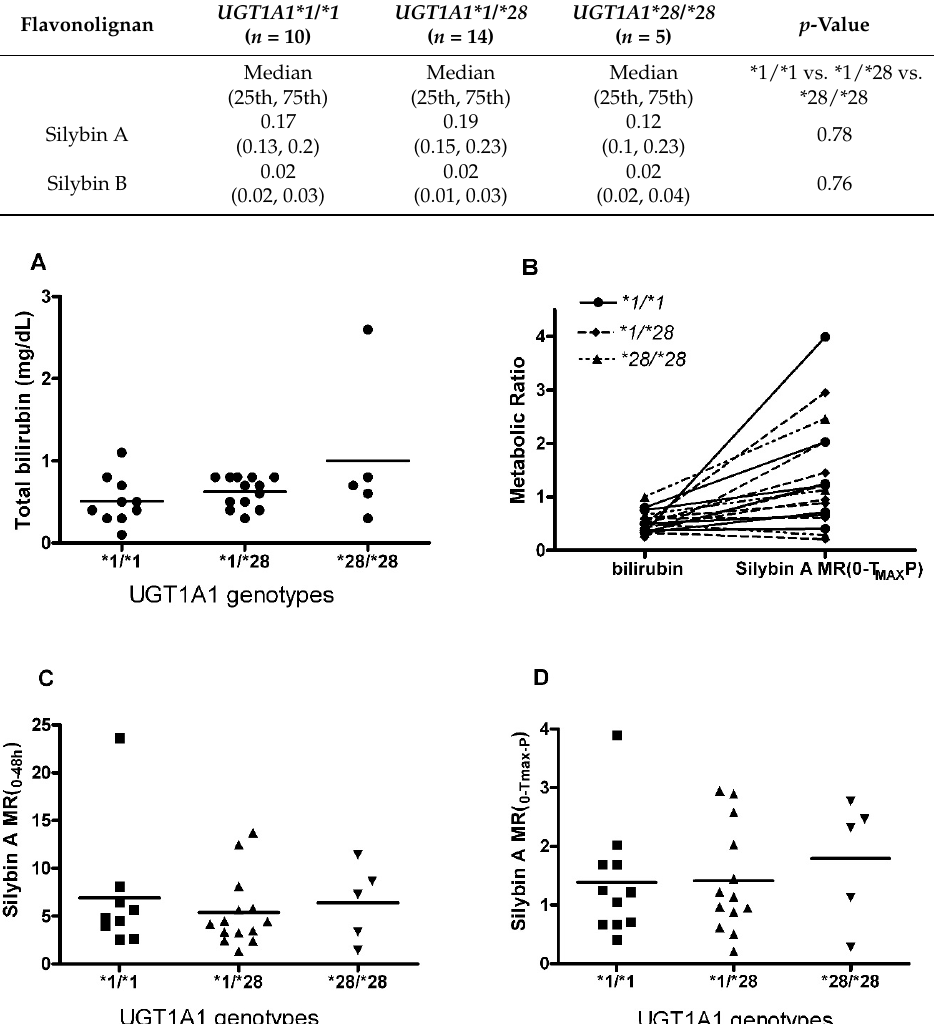
Figure 1. Bilirubin concentrations and silybin A metabolic ratios in different UGT1A1 promoter genotype groups. ( A ) Total bilirubin concentration in hepatitis C virus (HCV) and nonalcoholic fatty liver disease (NAFLD) patients with different UGT1A1 genotypes; ( B ) Relationship between silybin A (SA) metabolic ratio (MR) (0-Tmax-P) and ratio of conjugated bilirubin to total bilirubin; ( C , D ) SA MR (0–48 h) and MR (0-Tmax-P) with different UGT1A1 genotypes.